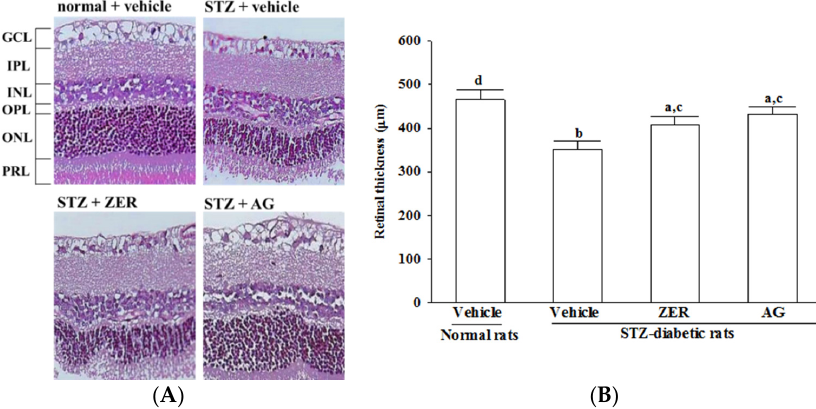
Figure 1. Presentation of ( A ) retinal morphology and ( B ) thickness in rats. STZ ‐ diabetic rats were administered 40 mg/kg/day ZER (STZ + ZER), or 50 mg/kg AG (STZ + AG) by oral gavage once daily administered 40 mg/kg/day ZER (STZ + ZER), or 50 mg/kg AG (STZ + AG) by oral